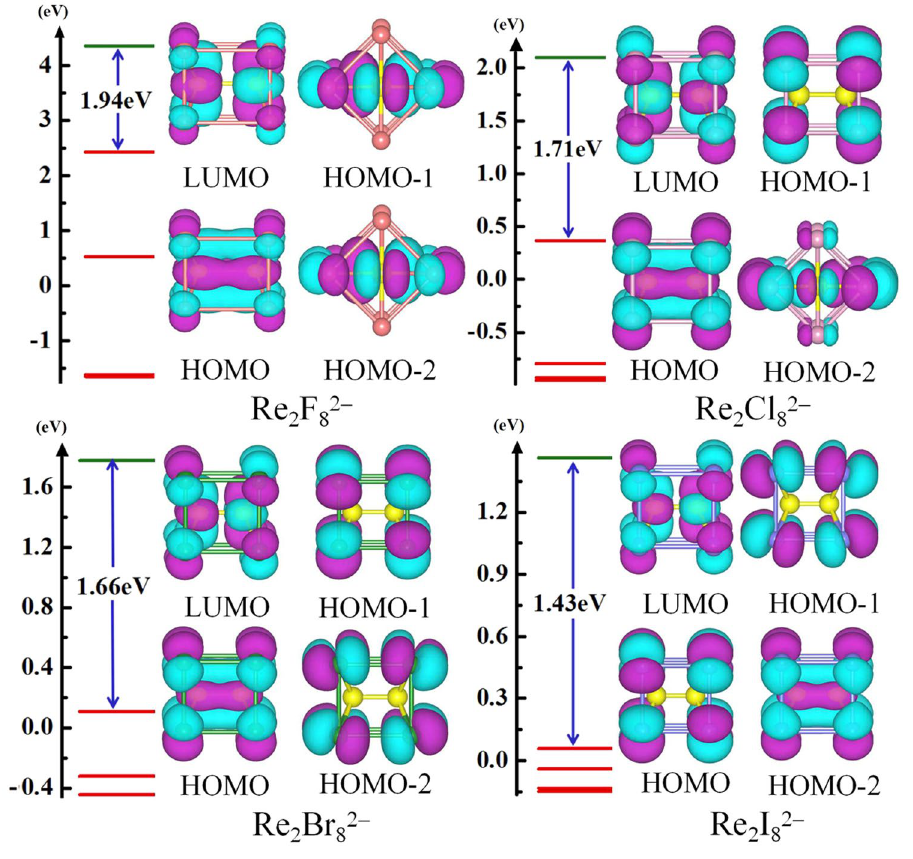
Figure 4. Molecular orbital maps and energy levels of Re 2 X 82 − (X = F, Cl, Br, I). The HOMO − LUMO energy gap is indicated (in